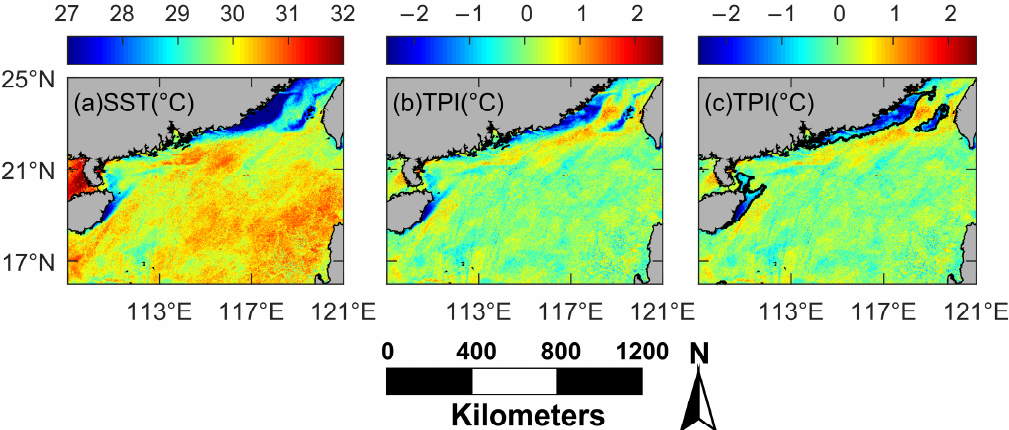
Figure 3. Upwelling region calculation process. ( a ) The Himawari-8 Sea Surface Temperature (SST) image on 17 July 2016; ( b ) Topographic Position Index (TPI) calculated from SST image; ( c ) upwelling region calculated by TPI (the region within black solid line).